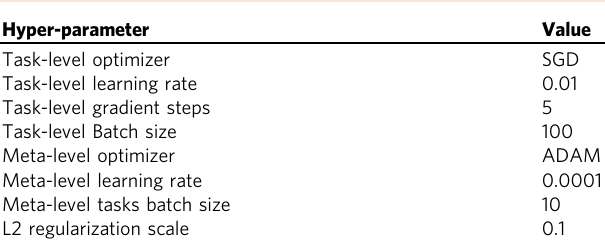
Table 1 Selected hyper-parameters for meta-learning ’